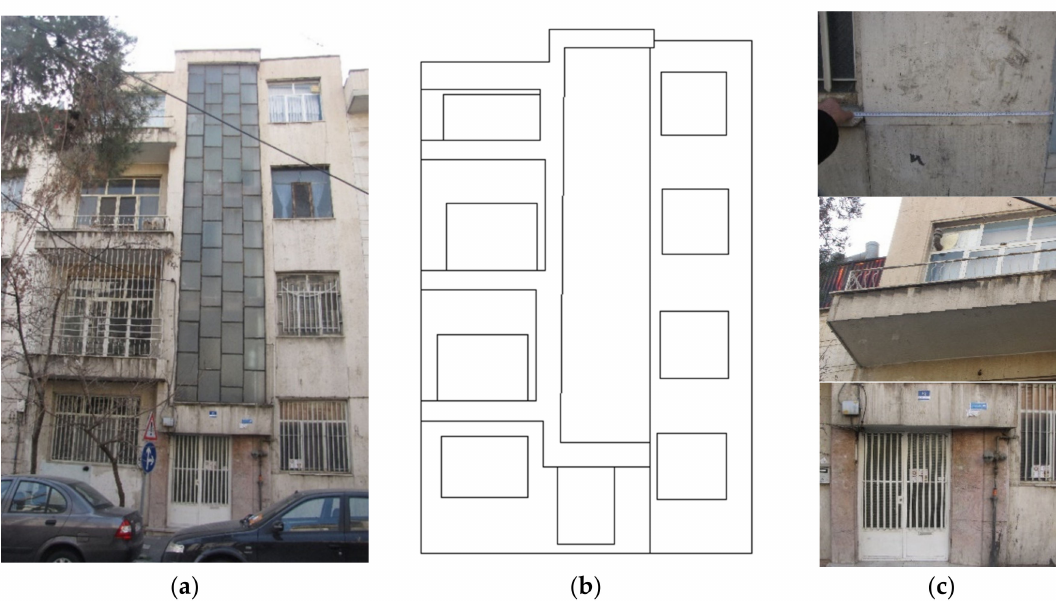
Figure 2. Illustrative example of one case study analysed in Tehran: ( a ) photograph of the façade; ( b ) diagrammatic sketch to represent the anomalies observed; ( c ) direct measurements and identification of different anomalies in the natural stone